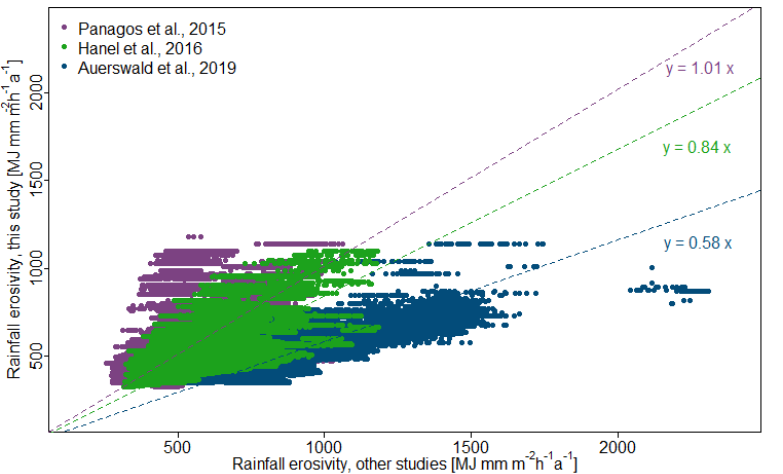
Figure 6. Comparison of rainfall erosivity [MJ mm m − 2 h − 1 a − 1 ] used here, with the data sets generated by other authors (Panagos et al. [95] for Europe, Hanel et al. [94] for the Czech Republic and Auerswald et al. [24] for Germany). Each point corresponds to a cell of the raster maps. The dashed lines show the linear models that were forced to pass through the origin. Figure created by the au- thors.